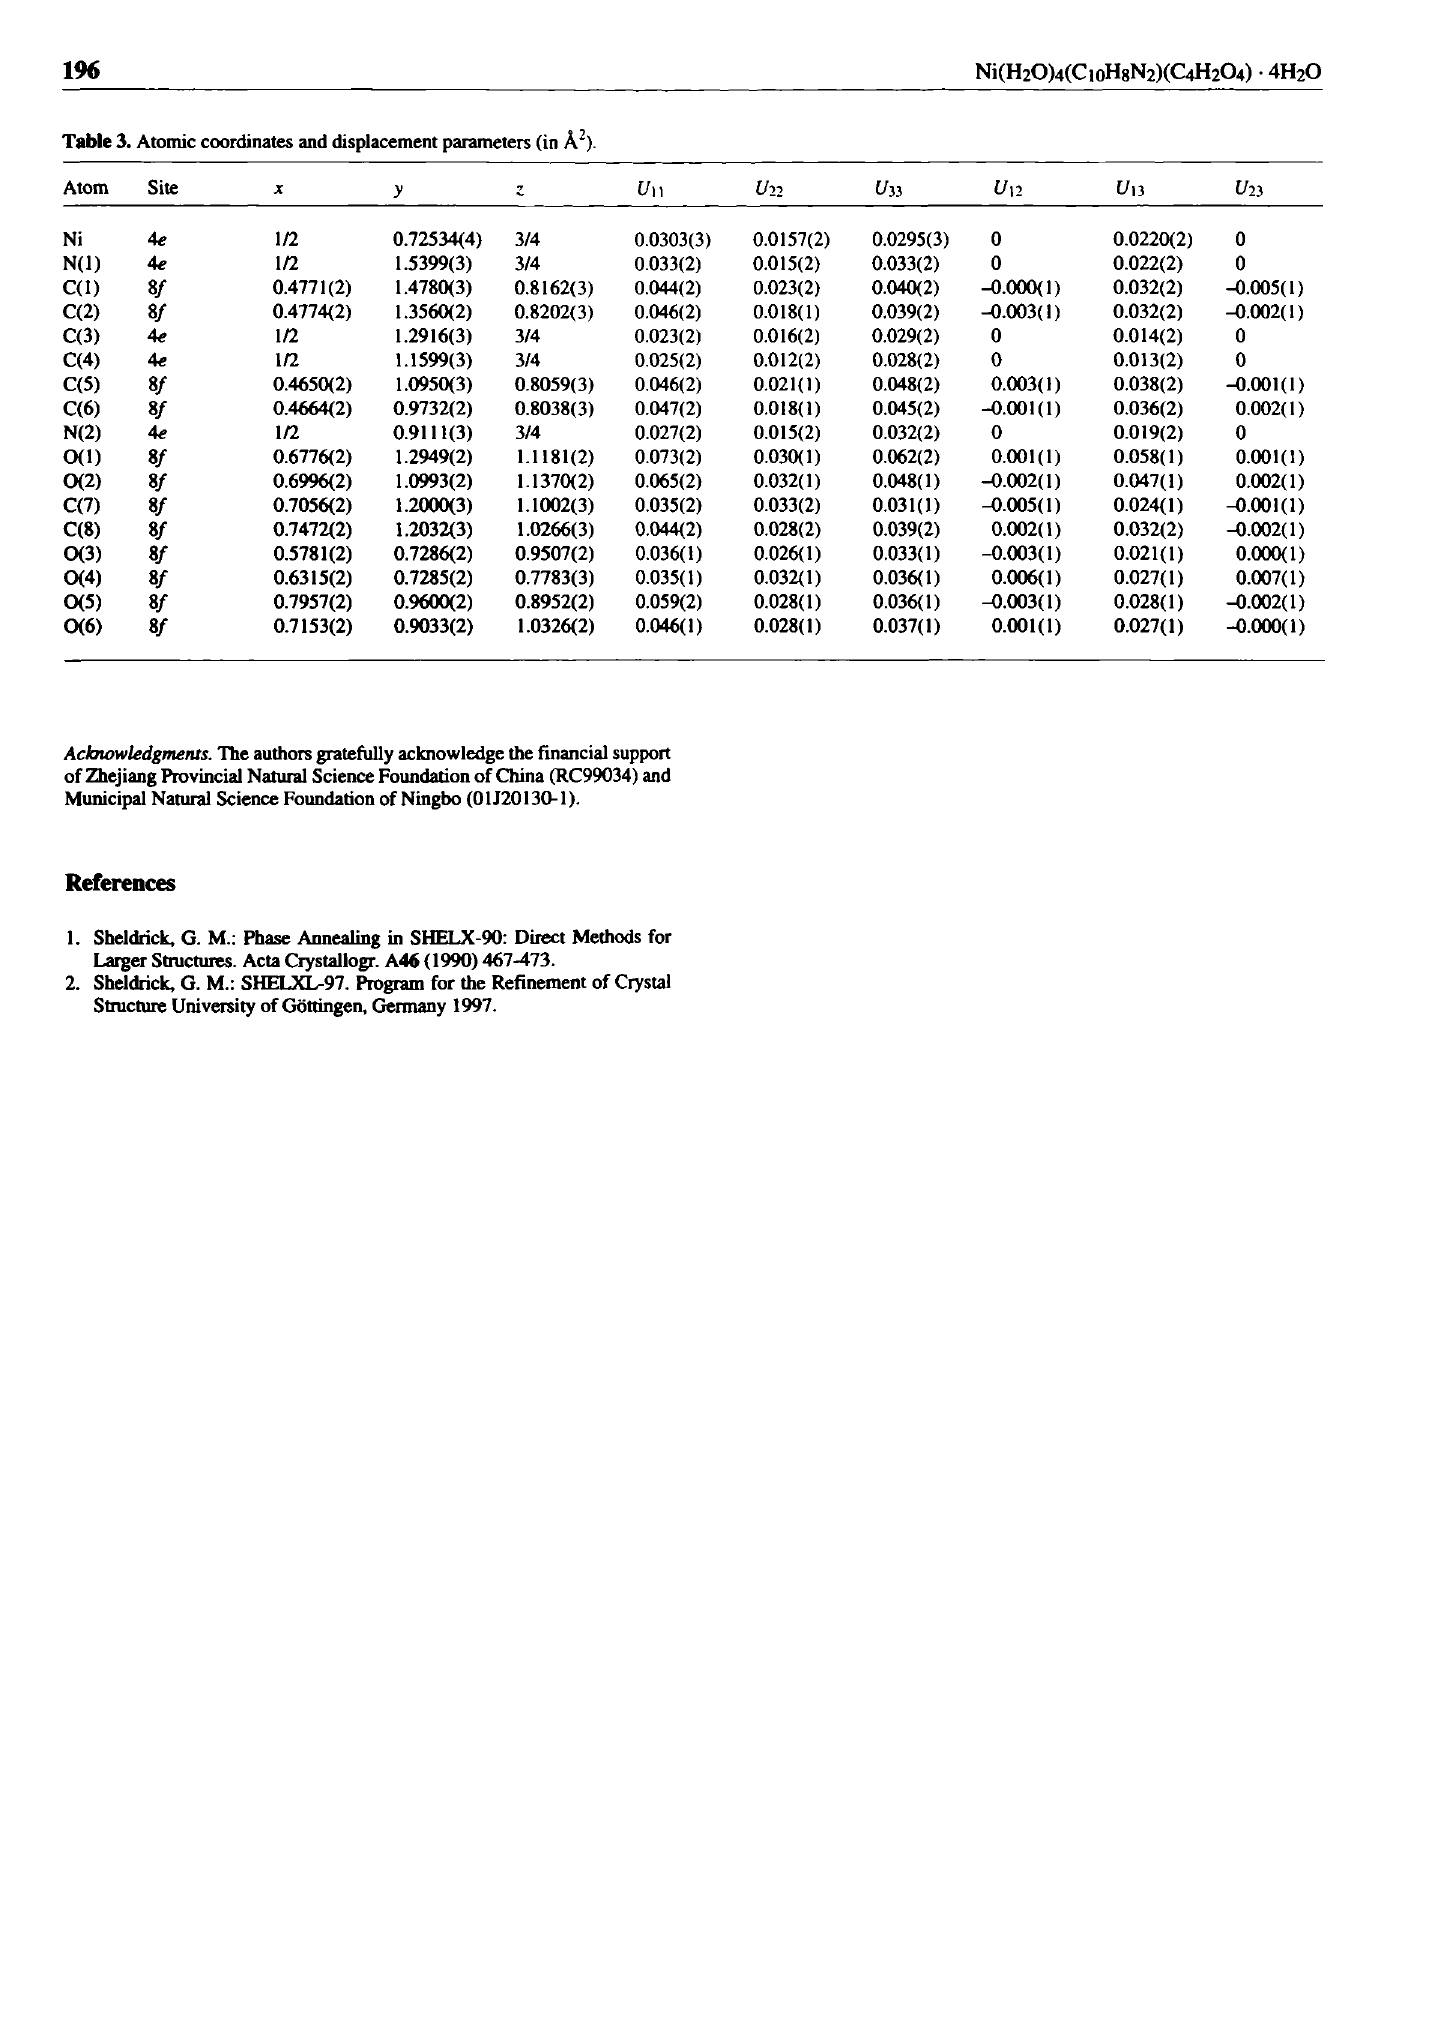
Table 3. Atomic coordinates and displacement parameters (in A 2